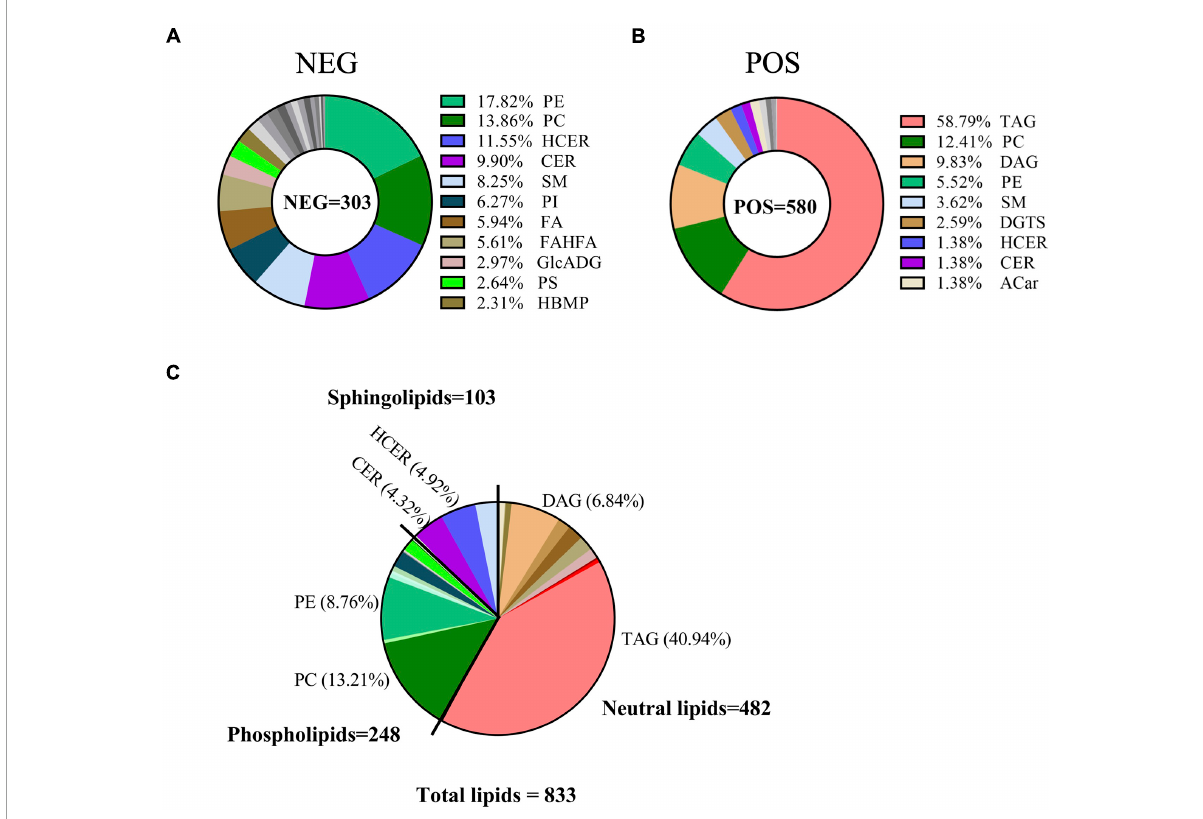
FIGURE2 Classification of breast milk lipids linking to GDM. Pie charts showed the classification of lipids in breast milk relating to GDM in negative ion mode (A) , positive ion mode (B) , and total identified lipids (C) , respectively.